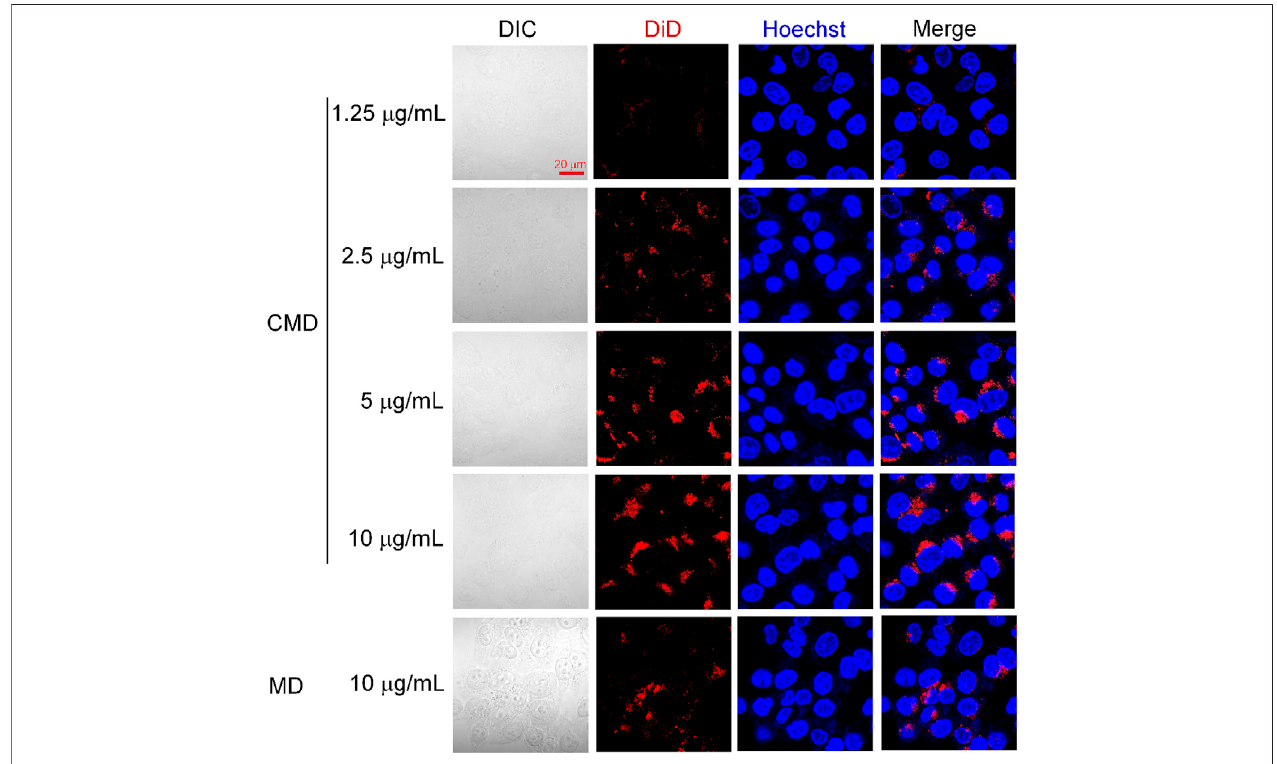
FIGURE 3 | Confocal microscopy images of Hela cells treated with the CMD at different DiD concentrations. Cell nuclei were stained blue with Hoechst.